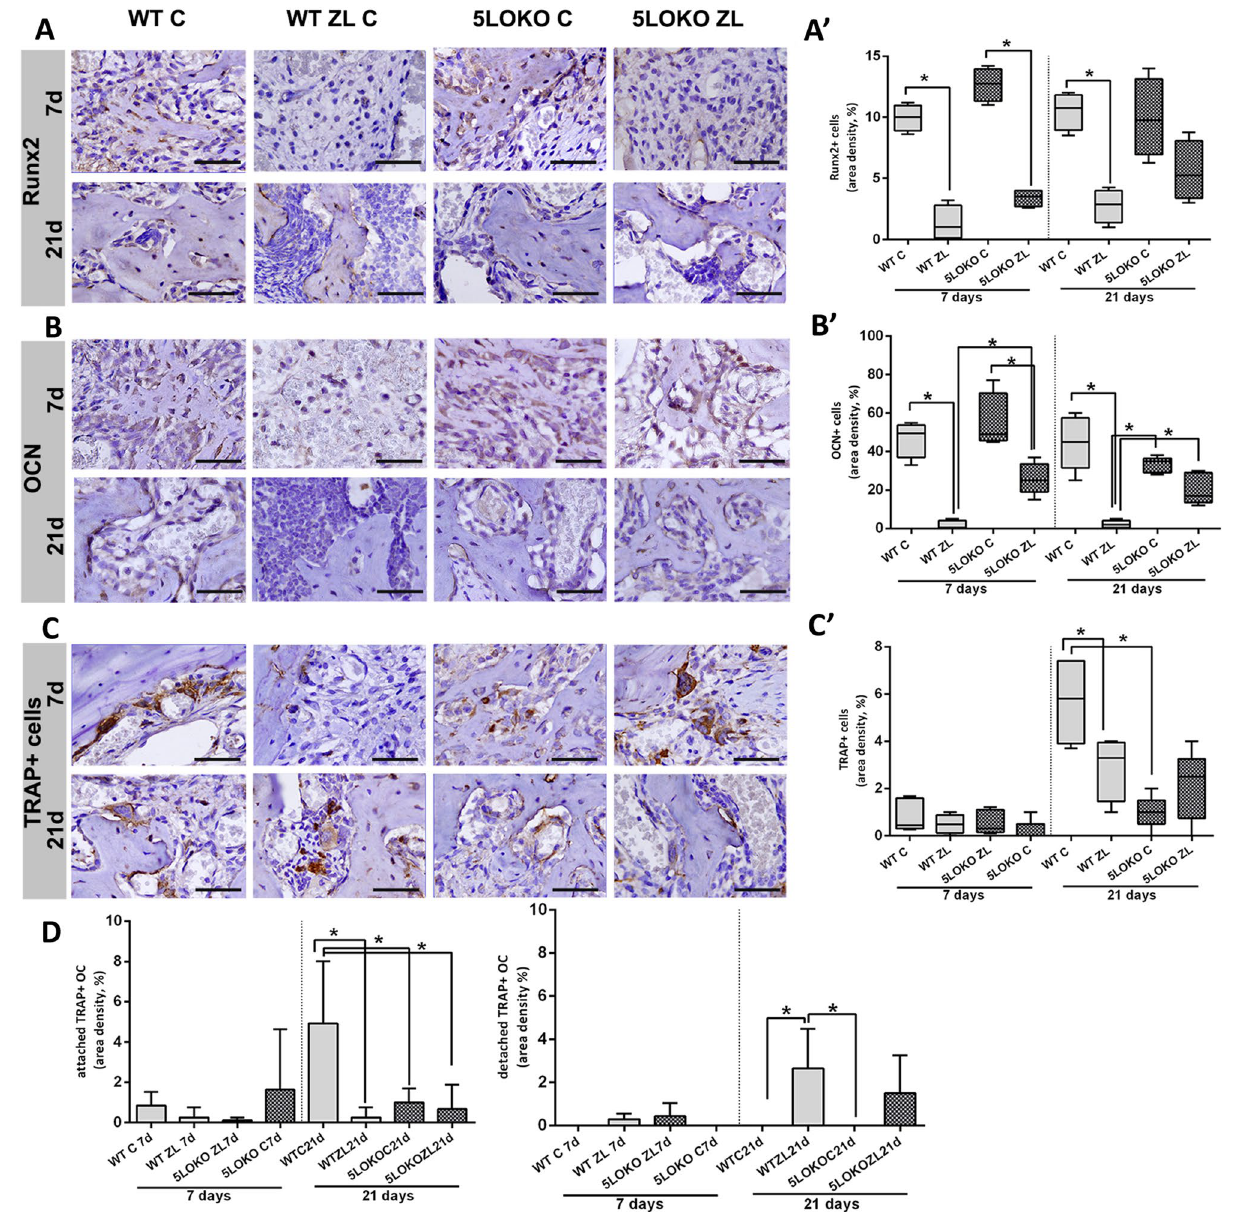
Figure 7. Immunolabeling and quantification for Runx2 + , OCN + and TRAP + cells at 7 and 21 days post tooth extraction in WT and 5LOKO mice, treated or not with ZL. Aged 129 Sv WT female mice received IP injections of 0.9% saline solution ( C ) or 250 μg/Kg (ZL groups) once a week, and upper right incisor were extracted at 4 week of each treatment. Mice were euthanized for maxillary bones removal after 7 days and 21 days post tooth extraction. ( A ) Representative transversal sections from the central area of alveolar sockets stained for Runx2 + cells ( A ), OCN + cells ( B ) and TRAP + cells ( C ), Scale bar: 50 µm. Quantitative and comparative analysis of Runx2 + cells ( A’ ), OCN + cells ( B’ ), and TRAP + cells ( C’ ) among groups. Quantitative results are presented with Box and whiskers (Min to Max). ( D , E ) Quantitative analysis for attached and detached TRAP + cells. Results are presented as the means (± SD) of area density (%). Symbol * indicates a statistically significant difference between groups (p < 0.05). DAB chromogen and counterstaining with Harris’